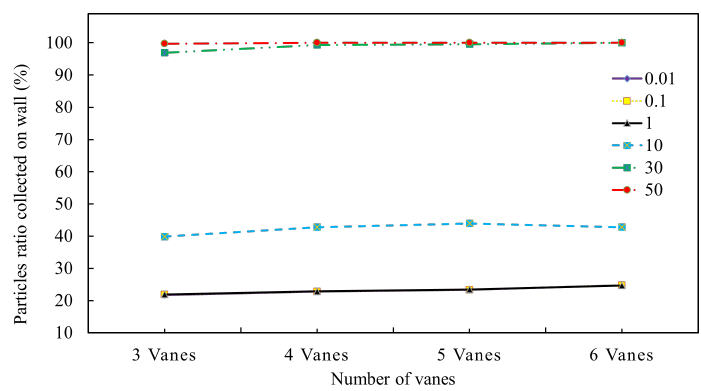
Figure 14. Effect of vane quantities with different particle